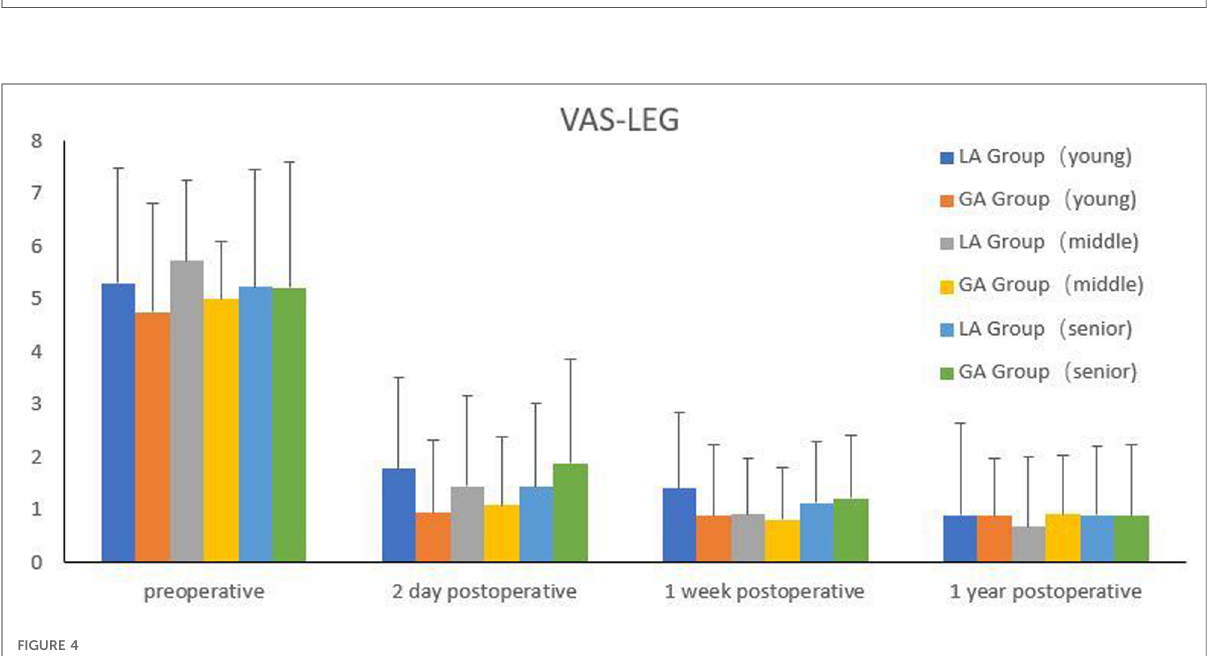
FIGURE 4 Comparison of VAS for leg pain between the two groups in different age